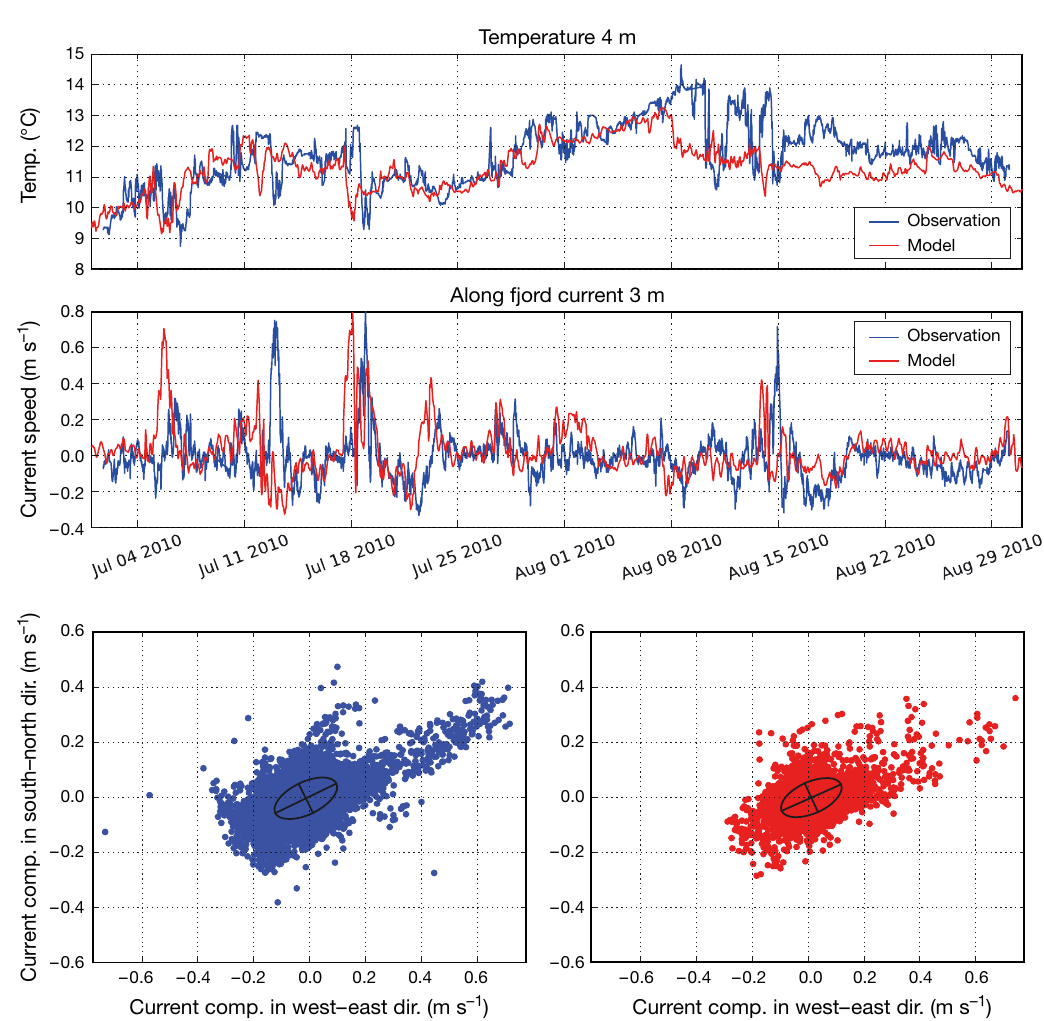
Fig. 4. Observed and simulated temperatures (top panel) and current in Nordfolda (green cross in Fig. 1). Along fjord current with positive current heading into the fjord (middle panel) and scatterplots of the velocity, with ellipse marking the standard deviation along and across the main current direction (lower panels). Observed data in blue, simulated data at the corres- ponding location in